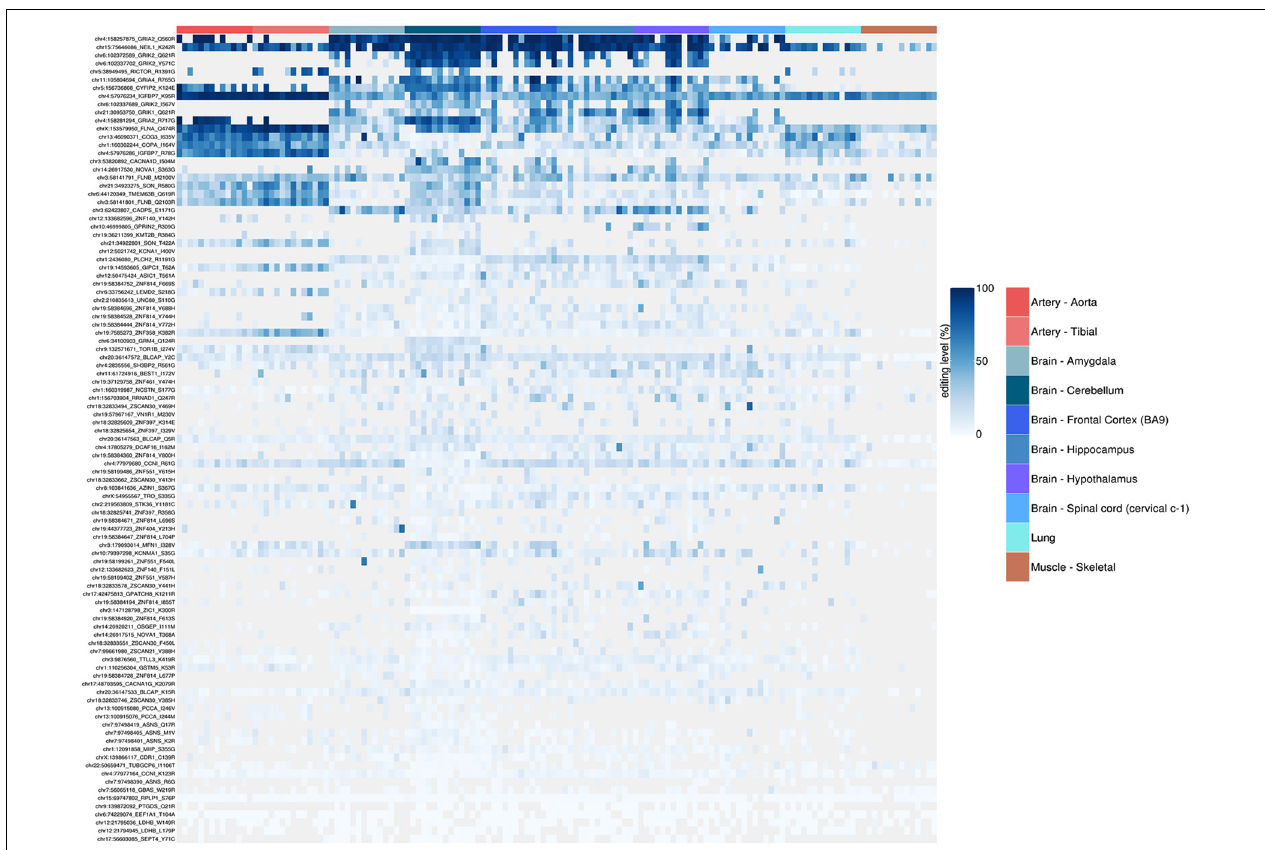
FIGURE 9 | Heatmap representing RNA editing levels at 99 selected recoding events. Body sites are reported in the same order as in the previous box-plots and follow the same color code. The hierarchical clustering (dendrogram not shown) of the recoding sites shows how the artery (both aorta and tibial) are characterized by a very peculiar and specific set of strongly ( > 90%) edited sites, thus suggesting a possible key functional role of these sites in the vascular system.